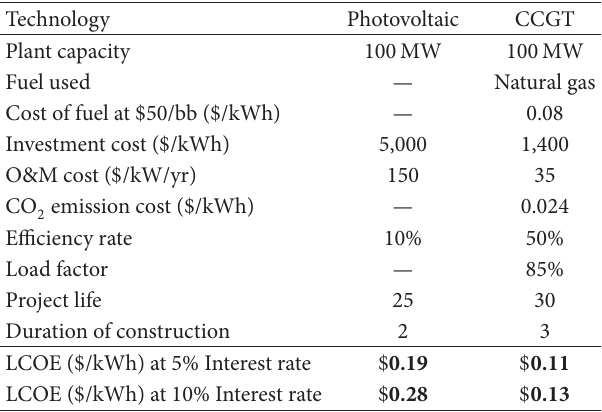
T 1: e LCOE for 100MW PV and CCGT power stations. Technology Photovoltaic CCGT Plant